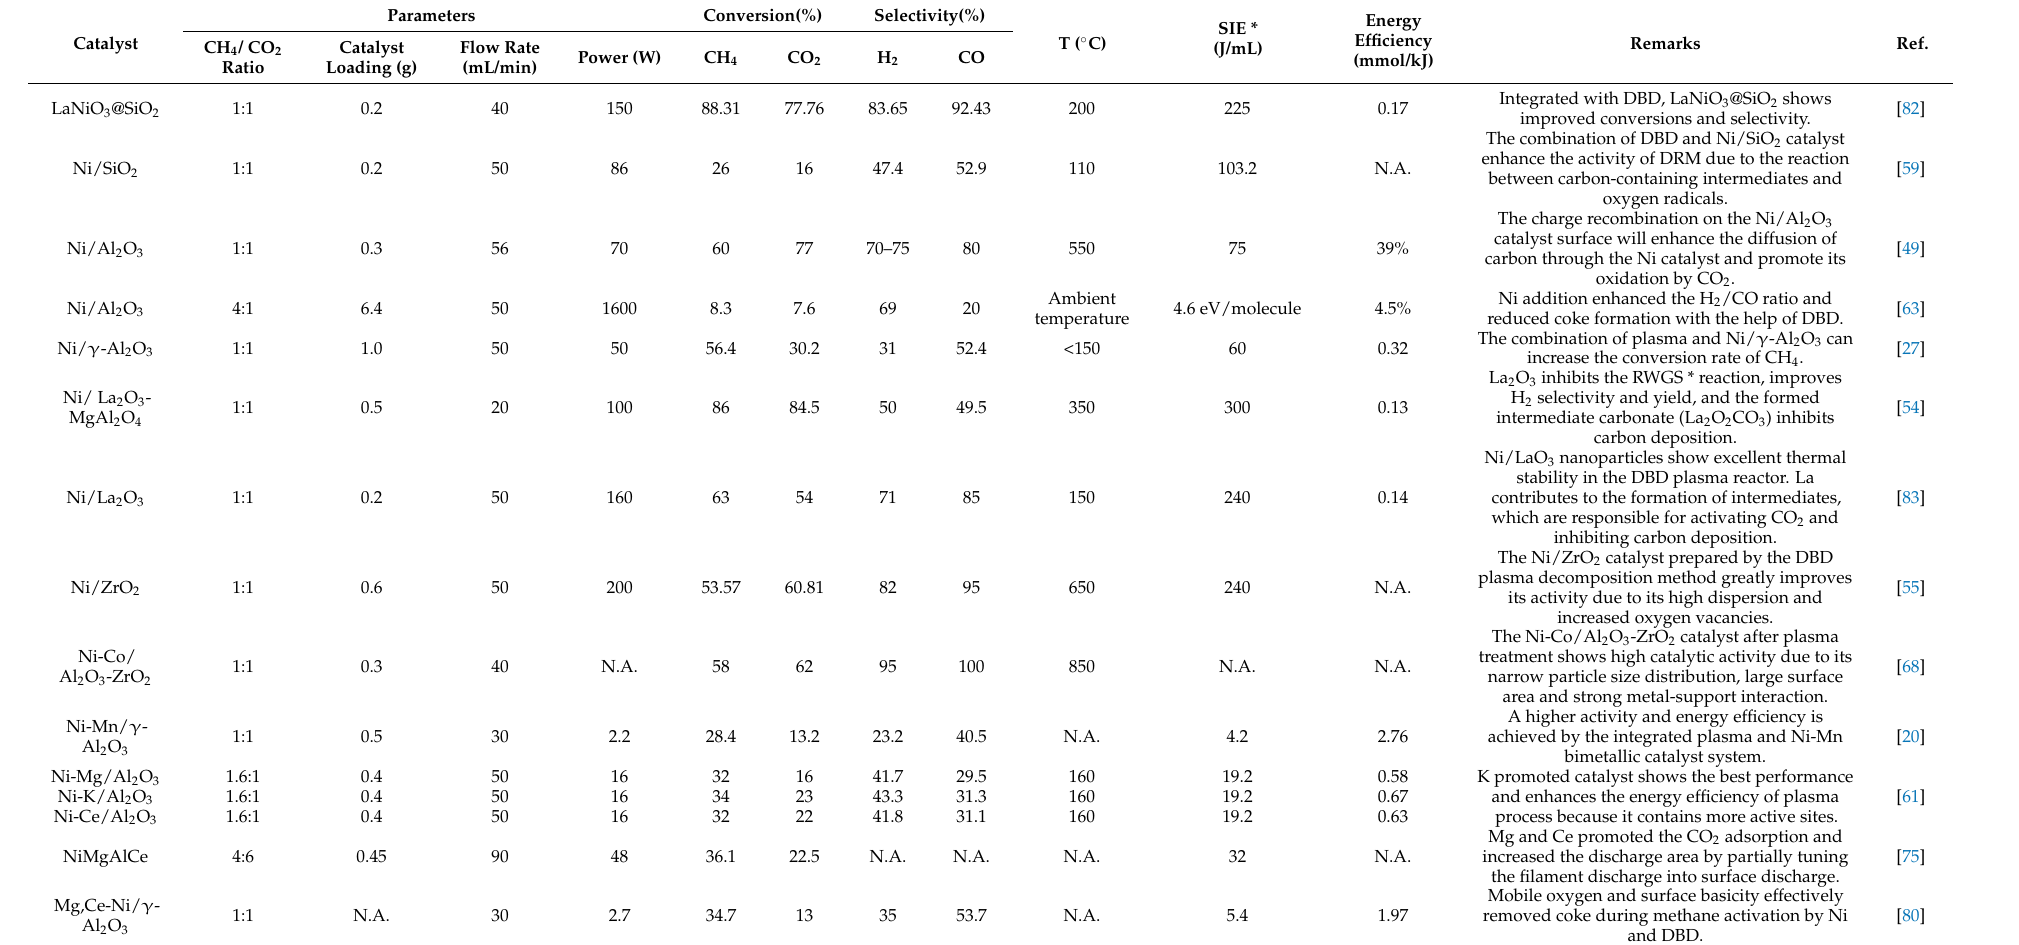
Table 1. Catalytic DRM activities of Ni-based catalysts integrated with DBD